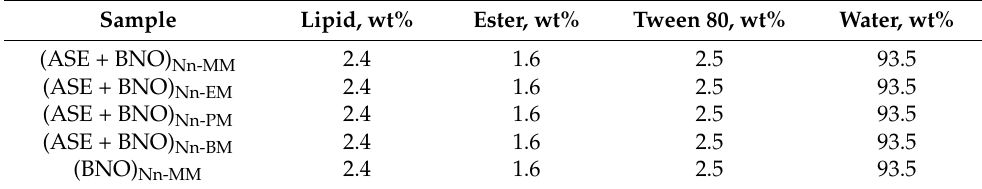
Table 3. Composition of nanoemulsions ( Nn ) with myristic acid esters (co-lipids).